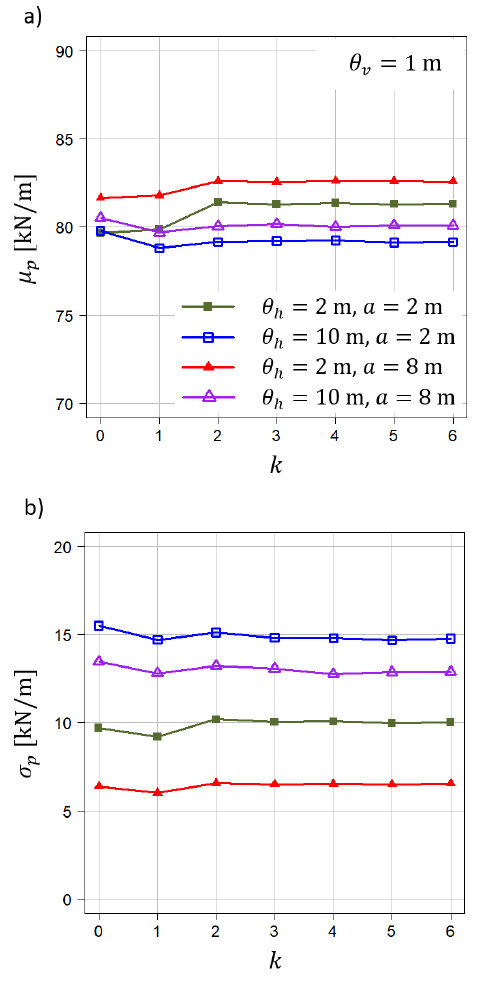
Figure 5: Bearing capacity mean values as a function of covariance matrix iteration number (a). Bearing capacity standard deviations as a function of covariance matrix iteration number (b). Case k =0 is for the constant covariance matrix. Results for two-layered soil, vertical scale of fluctuation θ =1 m,, foundation width b =1 m and averaging v lengths a =2 m and a =8